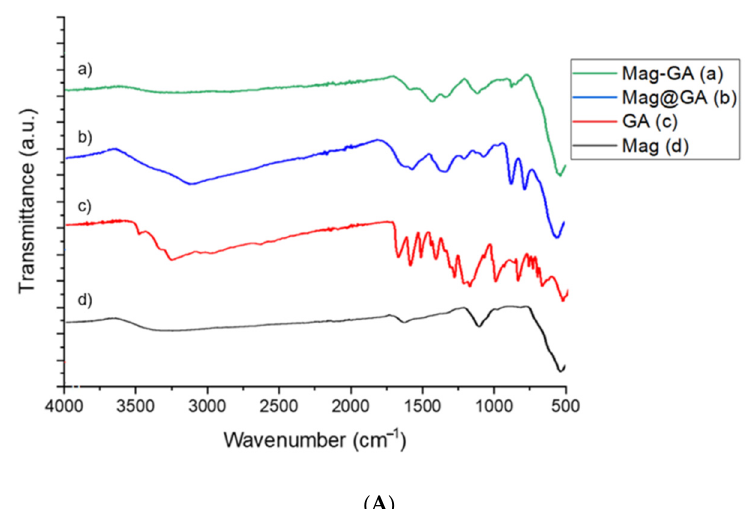
( B ) ( C ) Figure 1. Panels ( A – C ): FT-IR spectra of the investigated materials obtained from gallic acid ( A ), Trolox ( B ) and nordihydroguaiaretic acid ( C ).